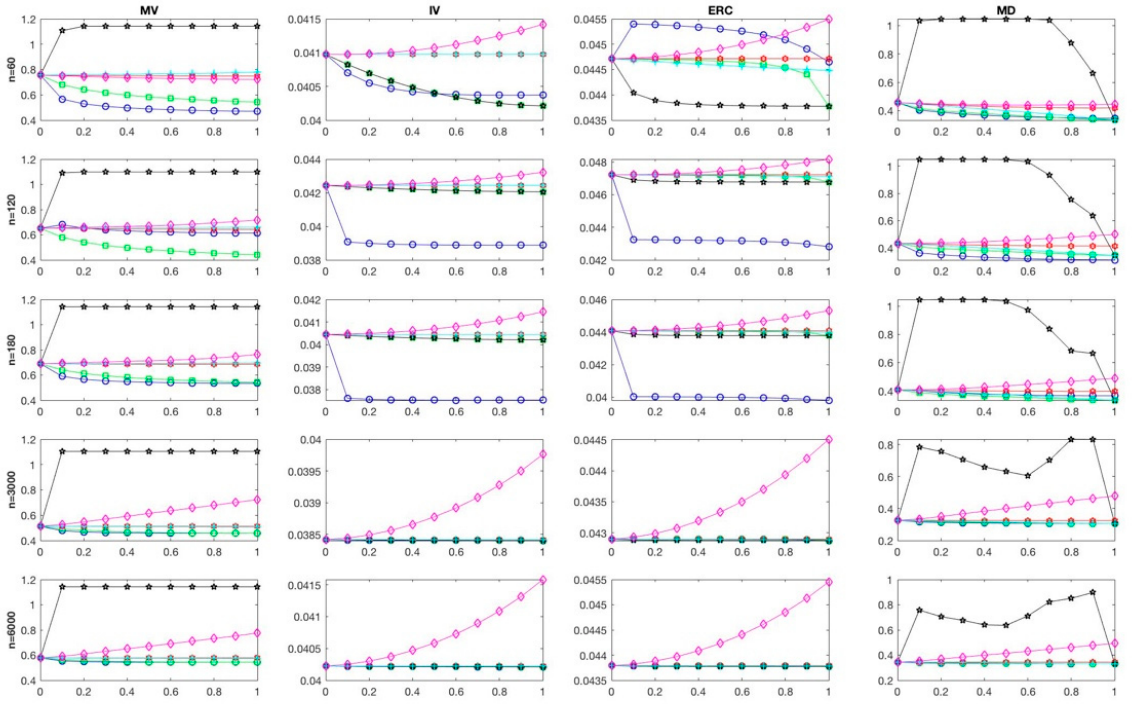
Figure 5. Frobenius norm for portfolio weights with regard to the shrinkage intensity parameter, when (cid:1868) = 100